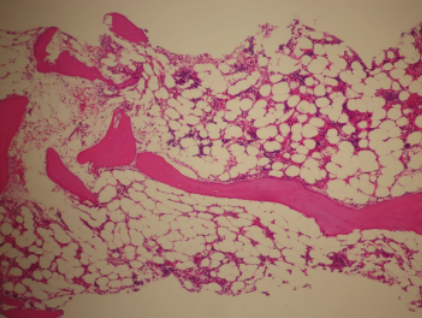
Figure 1: Bone marrow biopsy. The marrow was hypoplastic with no myelofibrosis.